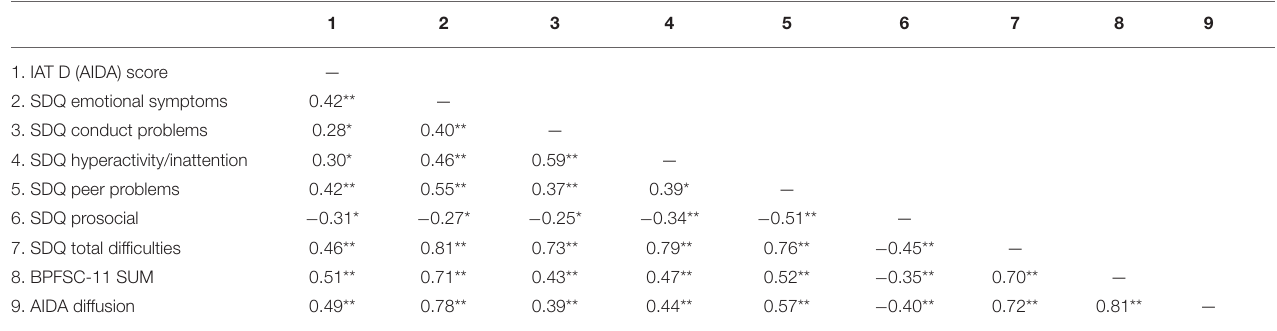
TABLE 2 | Intercorrelations between AIDA-IAT, self-reported mental-health difficulties, borderline symptoms, and identity diffusion.